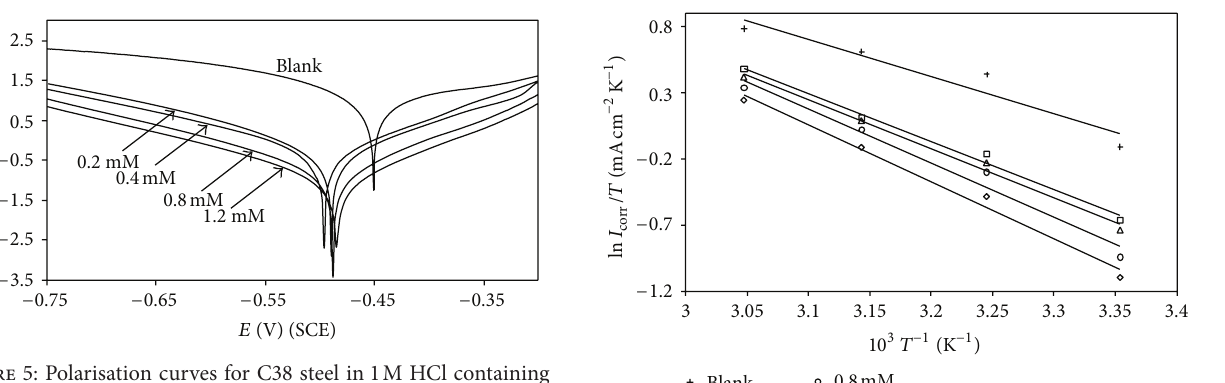
Figure 7: Arrhenius plots of corrosion ln (𝐼 HCl and at different concentrations of